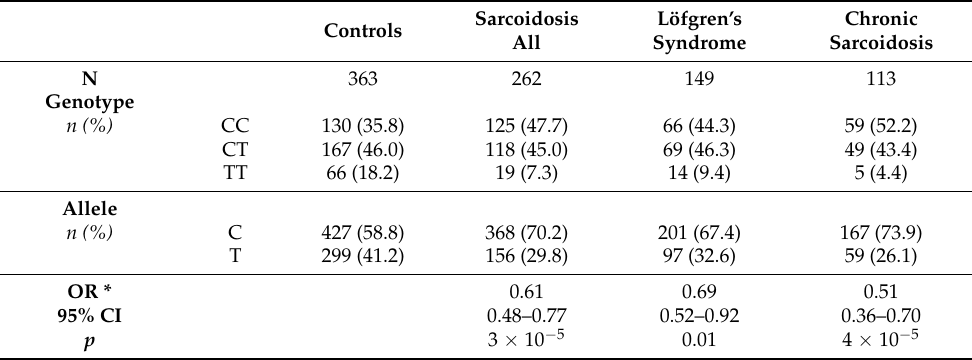
Table 2. ANXA11 rs1049550 genotype and allele frequencies of patients with Löfgren’s syndrome and chronic sarcoidosis.